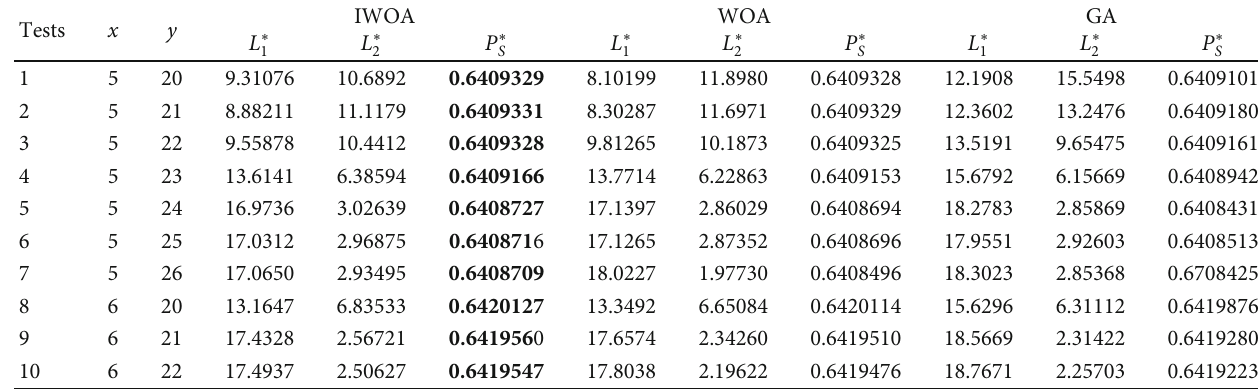
Table 5: Comparison of test